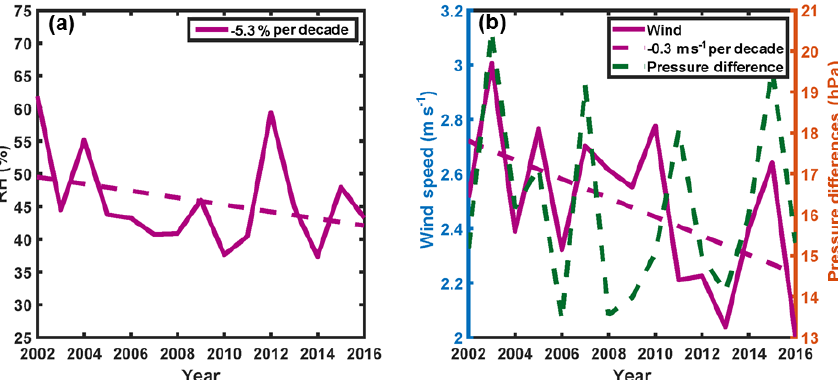
Figure 5. Simulated winter mean near-surface RH, wind speeds in Beijing with declining rates, and pressure difference indicating the intensity of East Asia winter